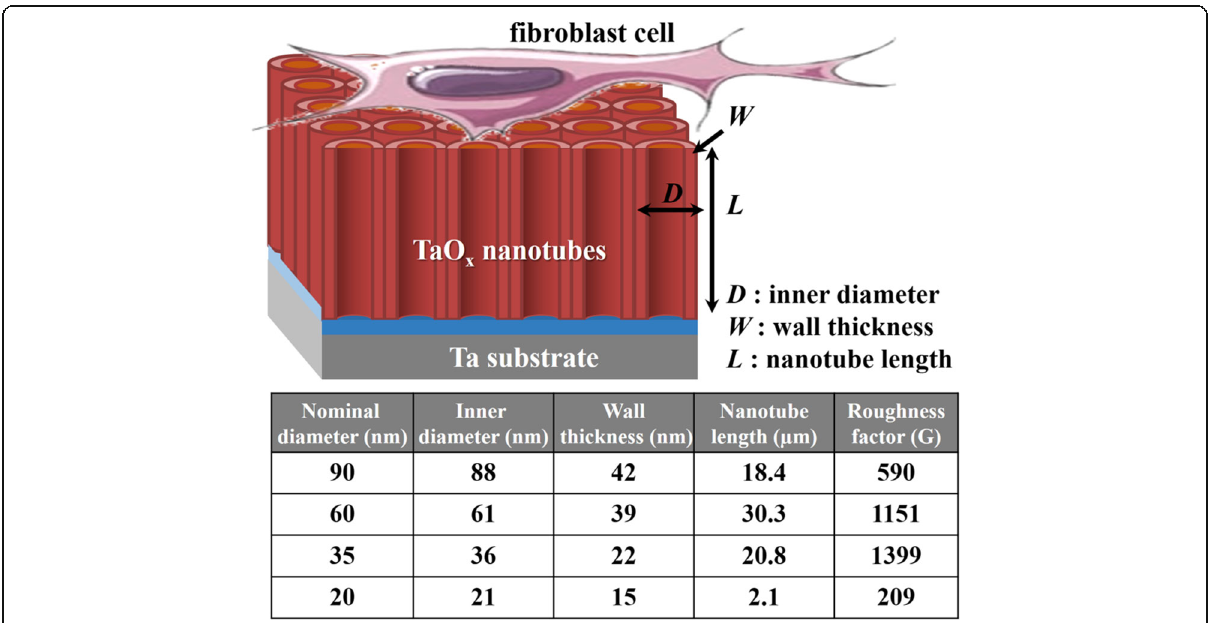
Fig. 5 Schematic diagram of an idealized nanotubular structure with inner diameter D , wall thickness W , and nanotube length L . The calculated